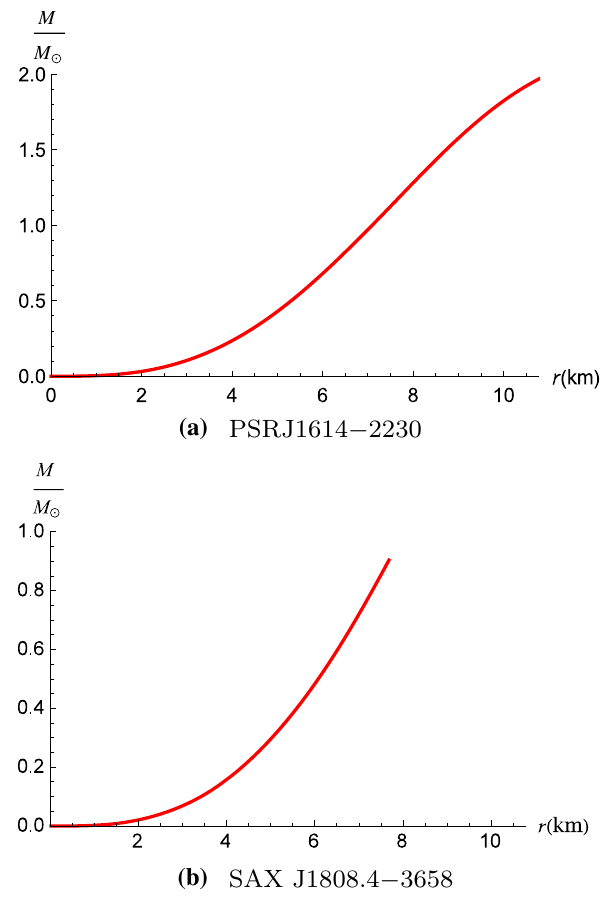
Fig. 12 Variation of the mass verses the